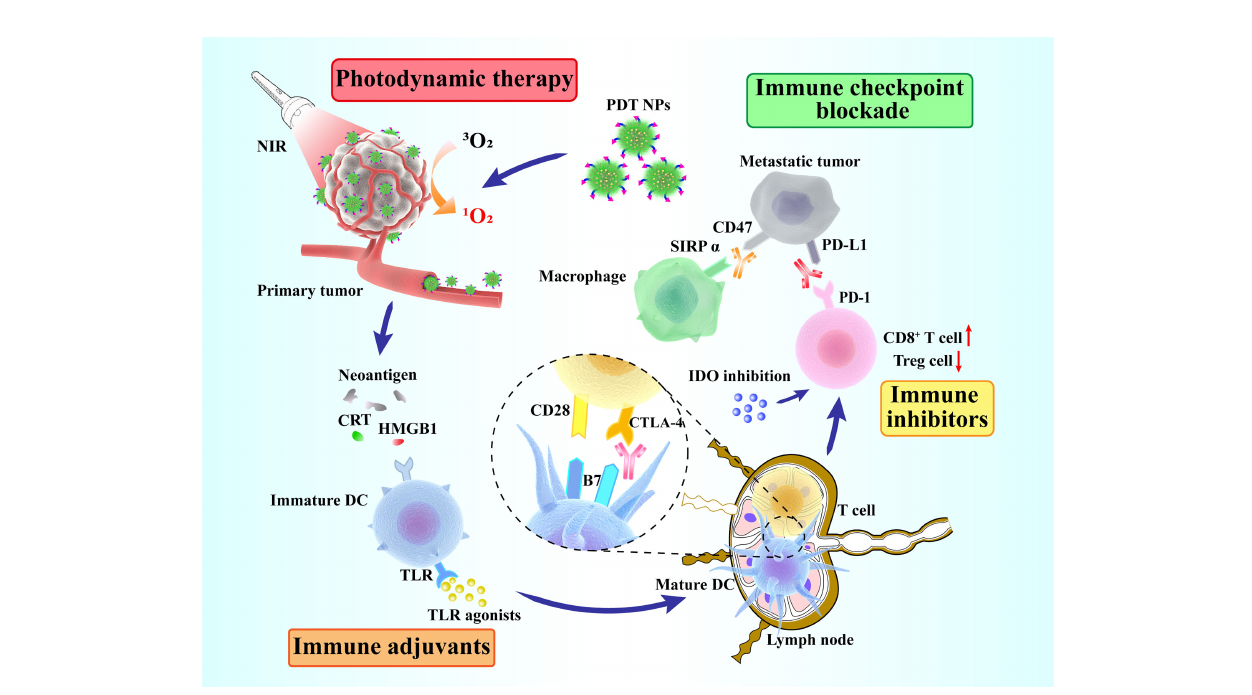
FIGURE 5 | Schematic overview of synergized photodynamic immunotherapy. Photodynamic therapy enhances the antitumor immune response, thus killing primary and distant tumors in combination with different immunotherapeutic strategies (immune adjuvants, immune inhibitors and immune checkpoint blockade).